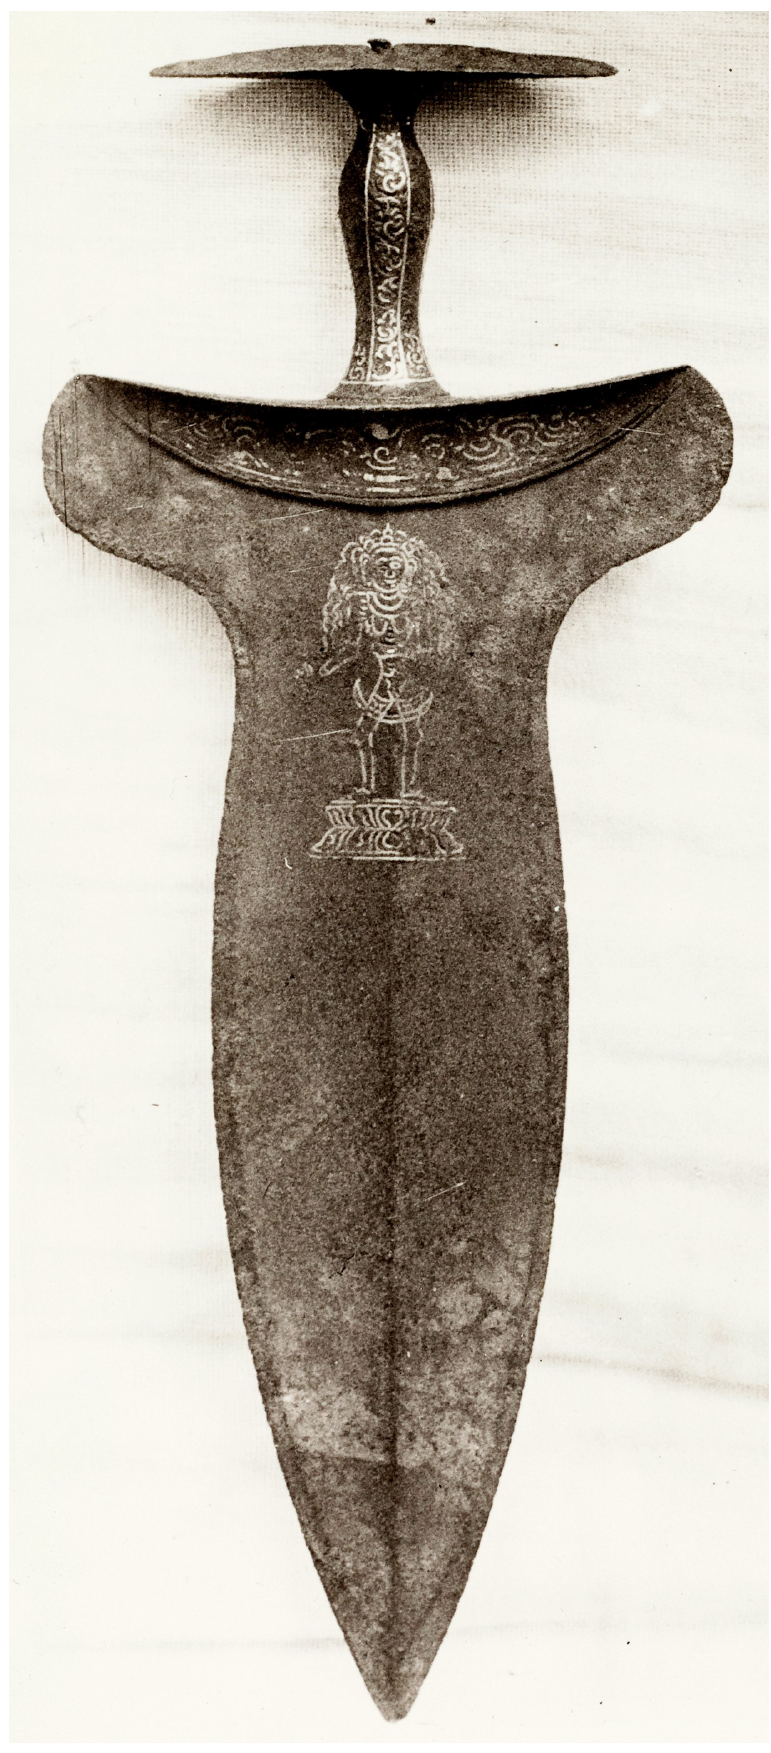
Figure 2 The Mandākinī sword and its female figure. Minangkabau regalia collection, Pagar Ruyung, West Sumatra. Licence: CC BY 4.0. Source: Leiden University shelfmark KITLV 163331